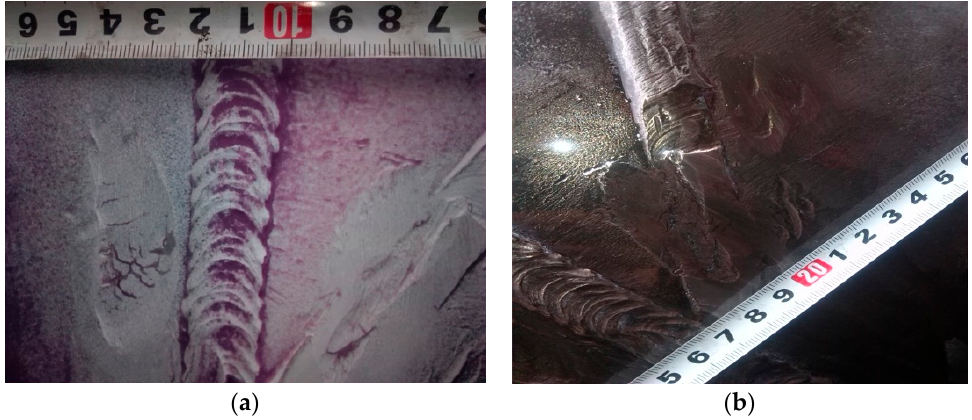
Figure 6. Inspections for external defects of pipeline girth weld: ( a ) dye penetrant; ( b ) magnetic particle.